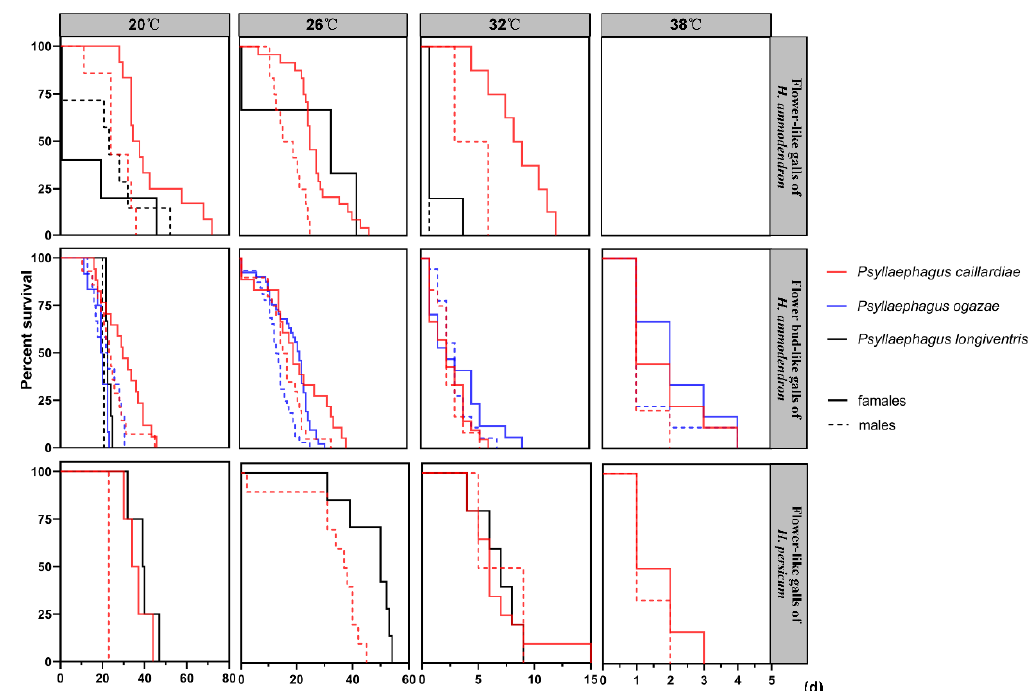
Figure 4. Survival curves of parasitoids of flower-like galls on Haloxylon at four different temperatures of 20, 26, 32, and 38 °C. Table 4. Sampling information and GenBank accession number for the deposited sequences generated from this study.